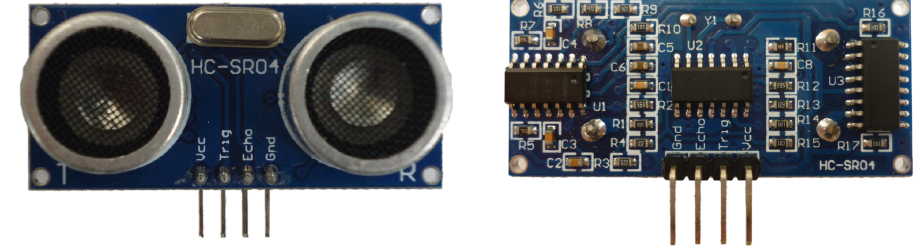
Figure 2. Picture of the HC-SR04 ultrasonic sensor. Top view in the left panel, bottom view in the right panel. The ultrasound emitter is labeled as “T” ( left ) and the receiver as “R” ( right ). It has 4 pins: “Vcc” and “Gnd” to provide the needed power, “Trig” to deliver the trigger signal that activates the ultrasound emission, and Echo”, which is activated when the echo is